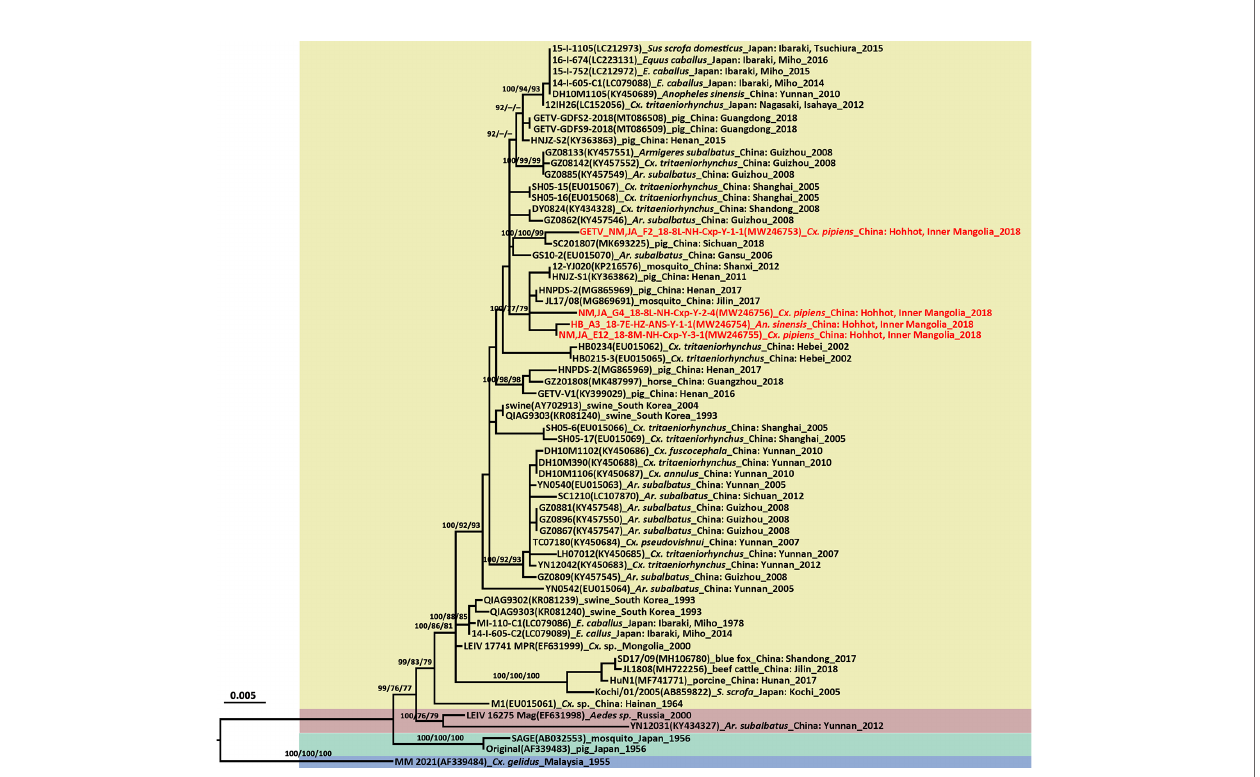
FIGURE 4 | Phylogenetic tree generated by Bayesian analysis of Getah virus (GETV) envelope gene. The virus strain, GenBank accession number, host, collection country and year are noted. The GETV sequences obtained in this study are marked in red. Bootstrap values (1,000 replicates, not shown for less than 75%) of Bayesian analyses, maximum likelihood and neighbor-joining are shown above the main lineages. The scale-bar indicates 0.005 substitutions per site. Sequences shaded sky blue represent the GETV Group I, those shaded aquamarine represent Group II, those shaded khaki represent Group III, those shaded rose-brown represent Group